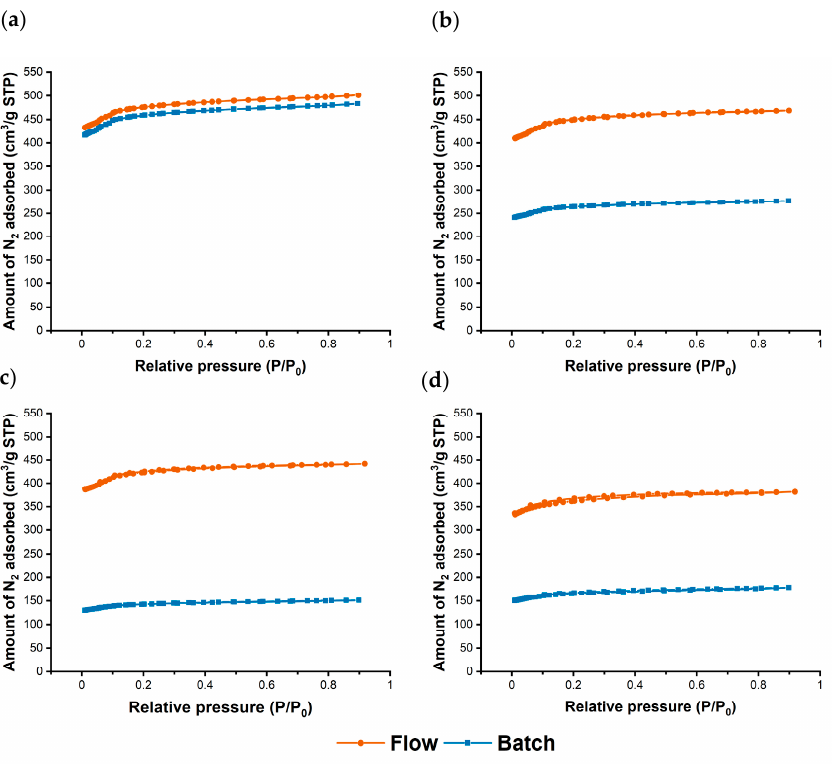
Figure 8. N 2 isotherms at 77 K for flow and batch electrosynthesis of HKUST-1 from ( a ) 0.01 M, ( b ) 0.05 M, ( c ) 0.078 M and ( d ) 0.1 M H 3 BTC.